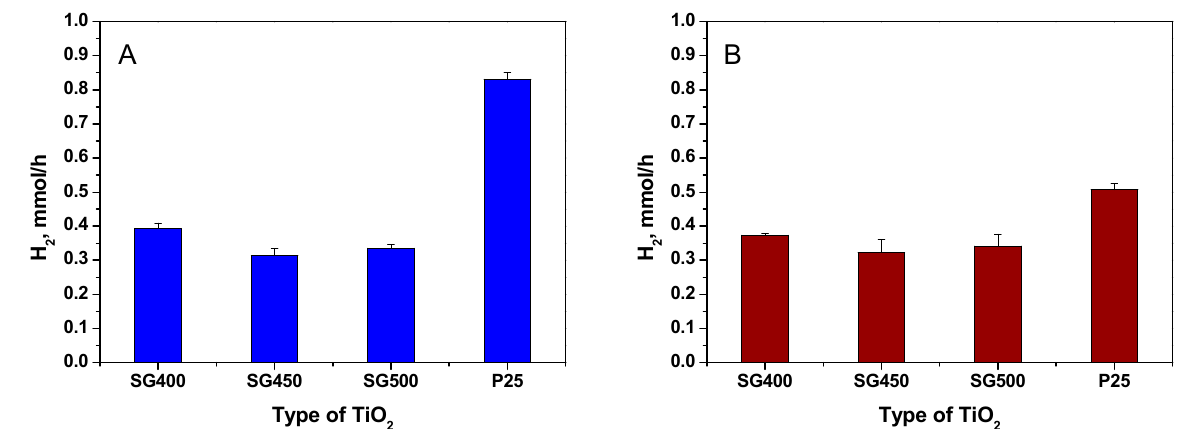
Figure 2. Hydrogen production rate in photocatalytic reforming reaction of methanol. Measured after 270 min; in the case of sol–gel-based samples, H 2 evolution data are averages of results from two parallel TiO 2 preparation. ( A ) co-catalyst formation by H 2 treatment; ( B ) co-catalyst formation by calcination. Error bars are based on measurements repeated two times.